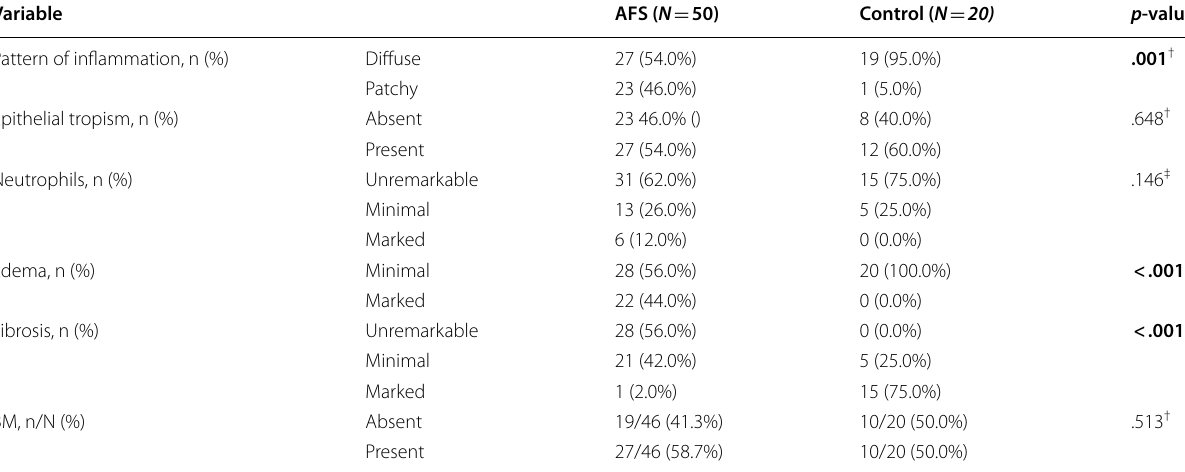
Table 1 Results of histopathology in cases and